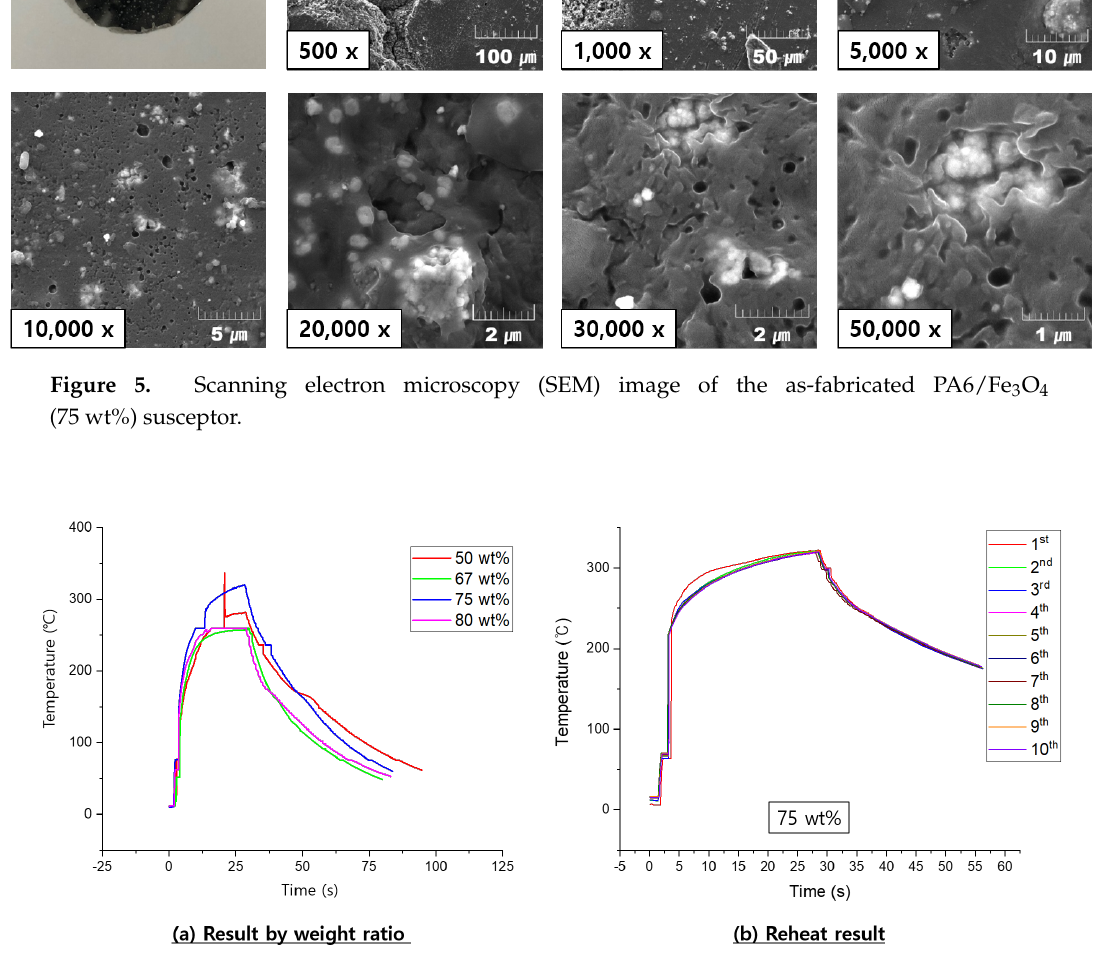
Figure 6. Induction heating results: ( a ) by Fe 3 O 4 weight percentage and ( b ) during 10 iterations of heating.